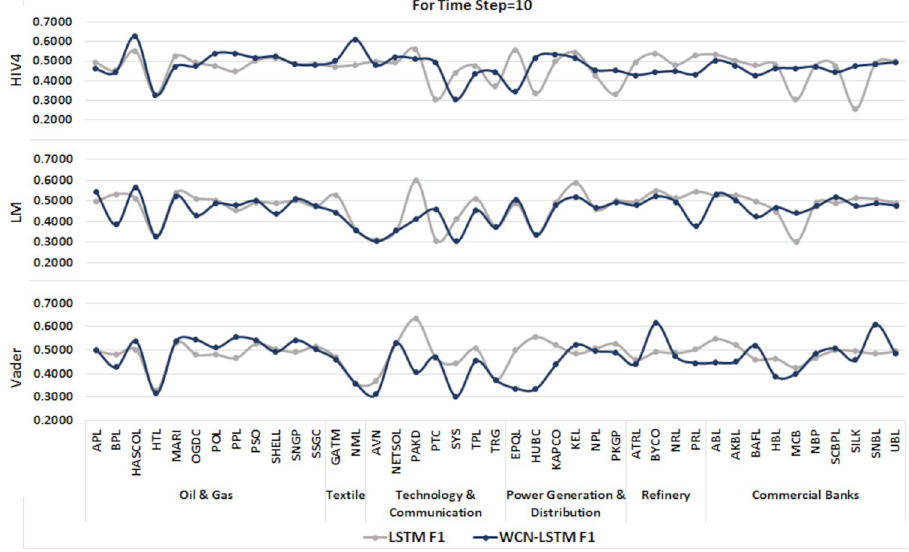
Fig 9. F1-score of prediction models by incorporating information from the last 10 days using the test